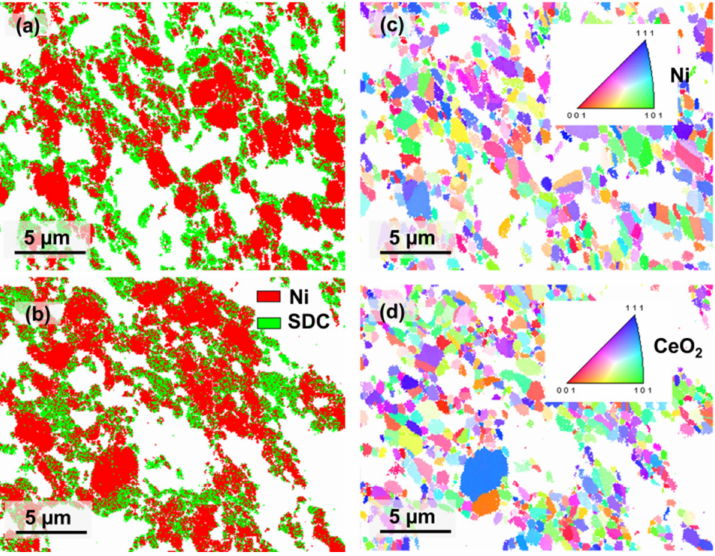
Figure 7. EBSD phase map and 2D inverse pole figure (IPF) of the reduced Ni–SDC cermet anode: ( a , c ) NS-GNP and ( b , d ) NS-24 cermet anode; reference triangles of each IPF map